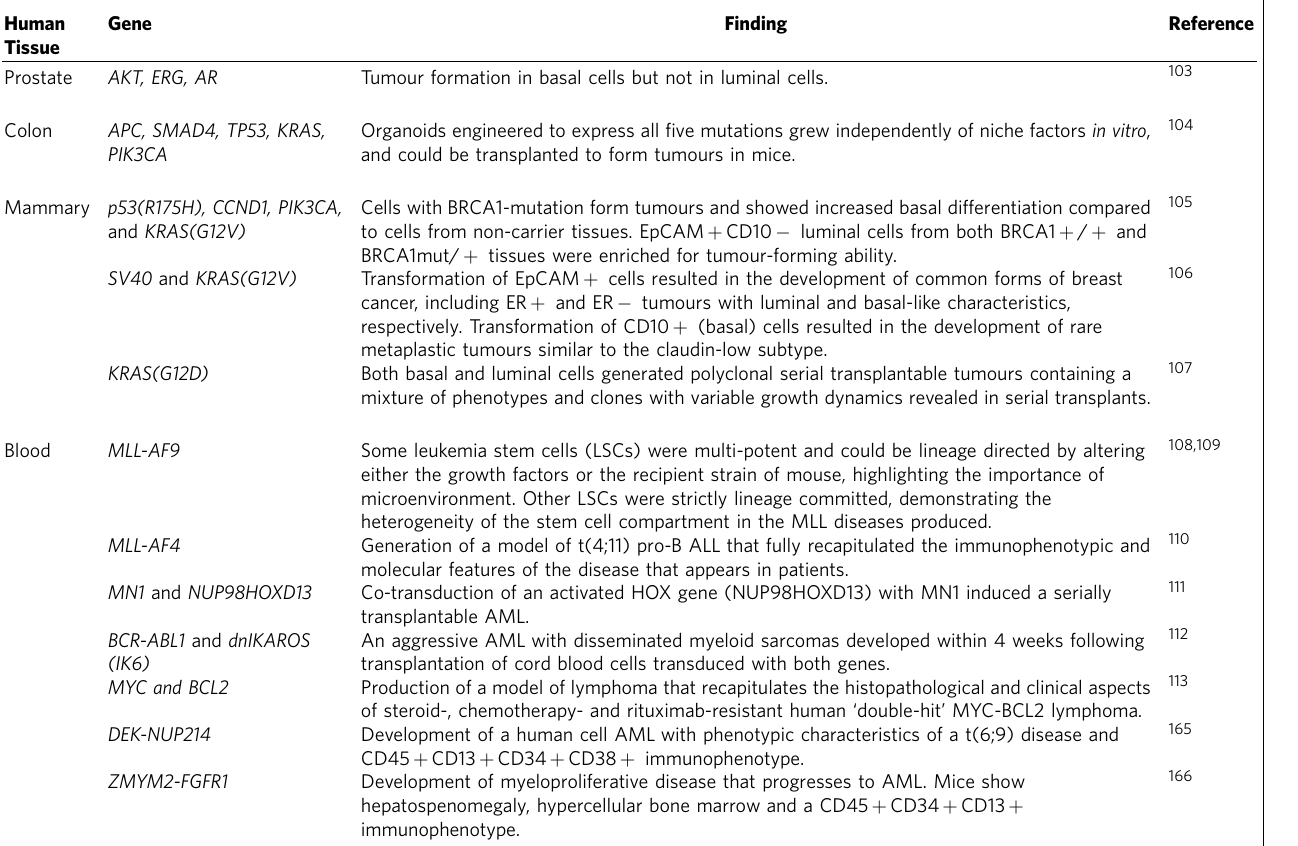
Table 1 | Examples of de novo tumour models from primary human cell sources. Human Gene Tissue